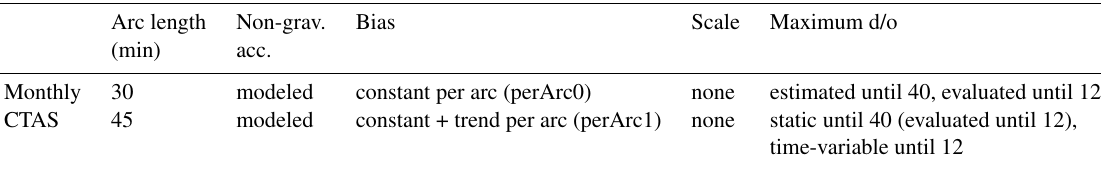
Table 3. Parameterization for our monthly solutions and for our estimation of CTAS signal terms. All results are subject to a 500km Gaussian filter.